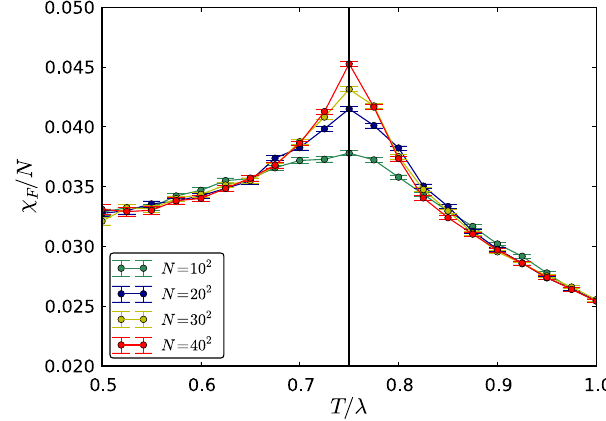
FIG. 4. Fidelity susceptibility per site of a Bose-Hubbard model on a square lattice at unit filling. The vertical line indicates the critical point determined in Ref. [67]. The inset shows the data collapse of the scaled fidelity susceptibility. Fig. 4 shows the scaled fidelity susceptibility χ F L − 2 = ν versus ½ð λ =U Þ − ð λ =U Þ c (cid:2) L 1 = ν according to the scaling law